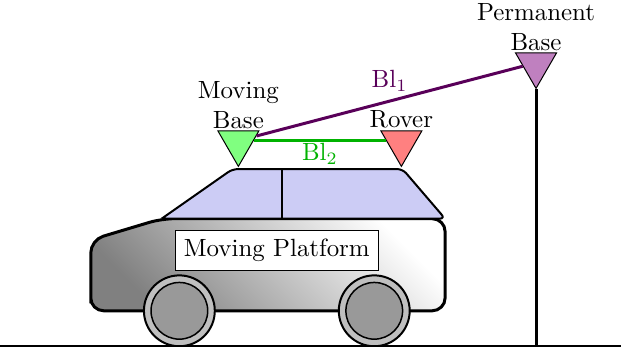
Figure 1. Receiver types in the multiple baseline